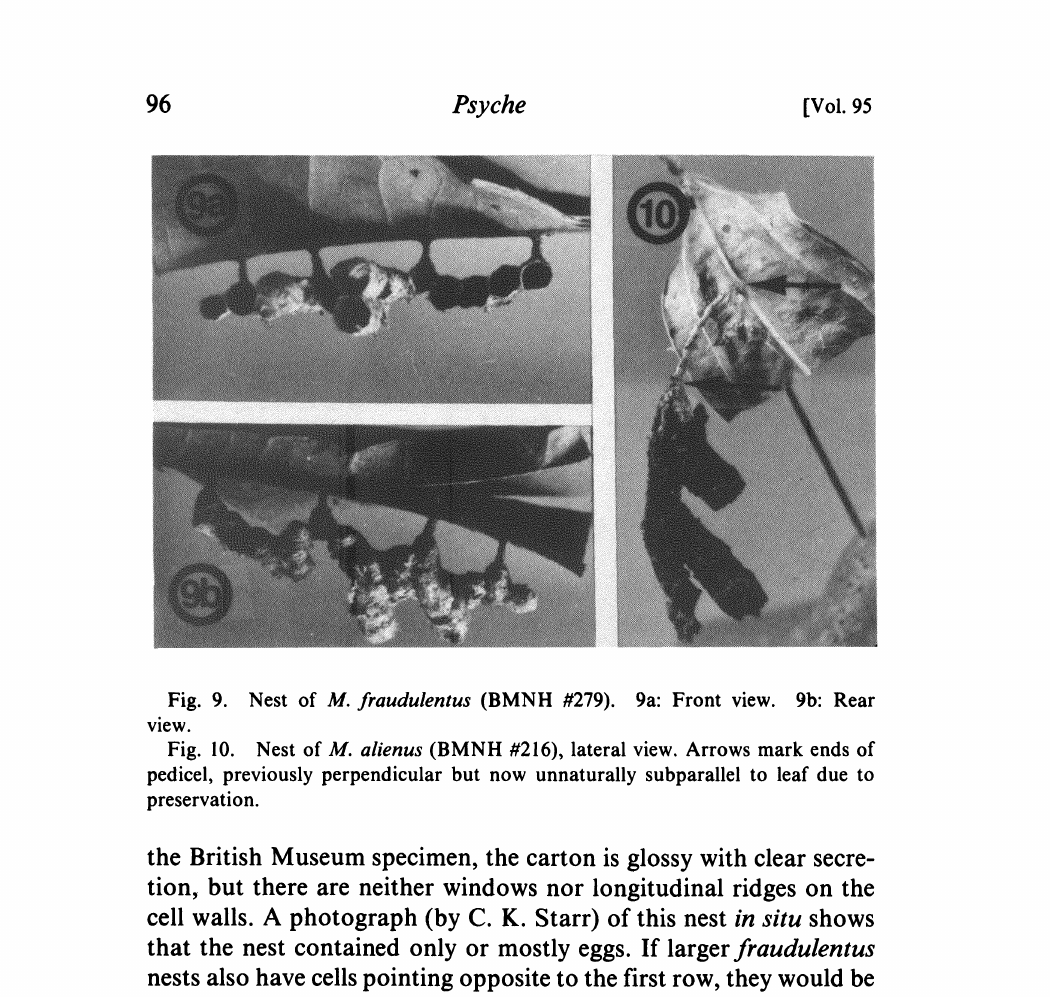
Fig. 9. Nest of M. fraudulentus (BMNH #279). 9a: Front view. 9b: Rear view. Fig. 10. Nest of M. alienus (BMNH #216), lateral view. Arrows mark ends of pedicel, previously perpendicular but now unnaturally subparallel to leaf due to